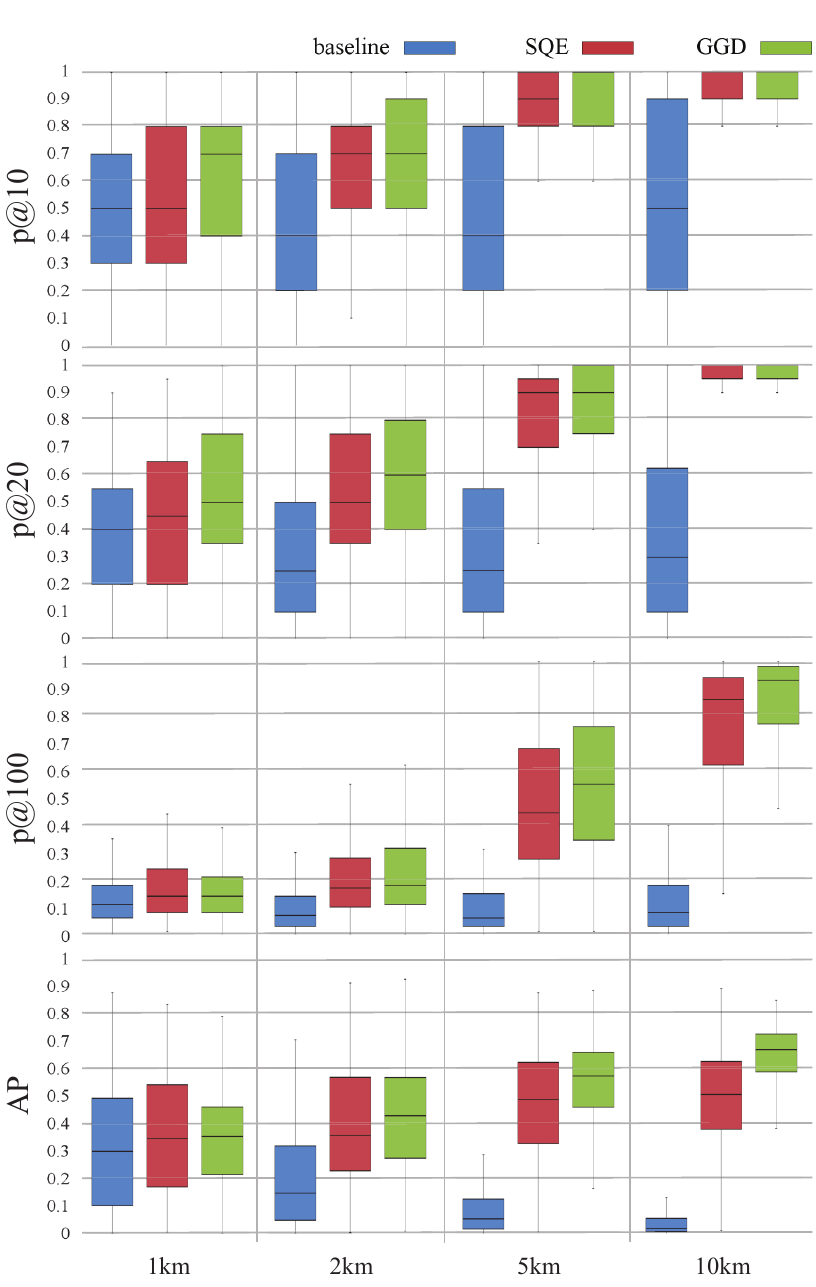
Figure 8: Summary statistics for P@10, P@20, P@100 and AP for spatial queries using four different search radii and three GIR